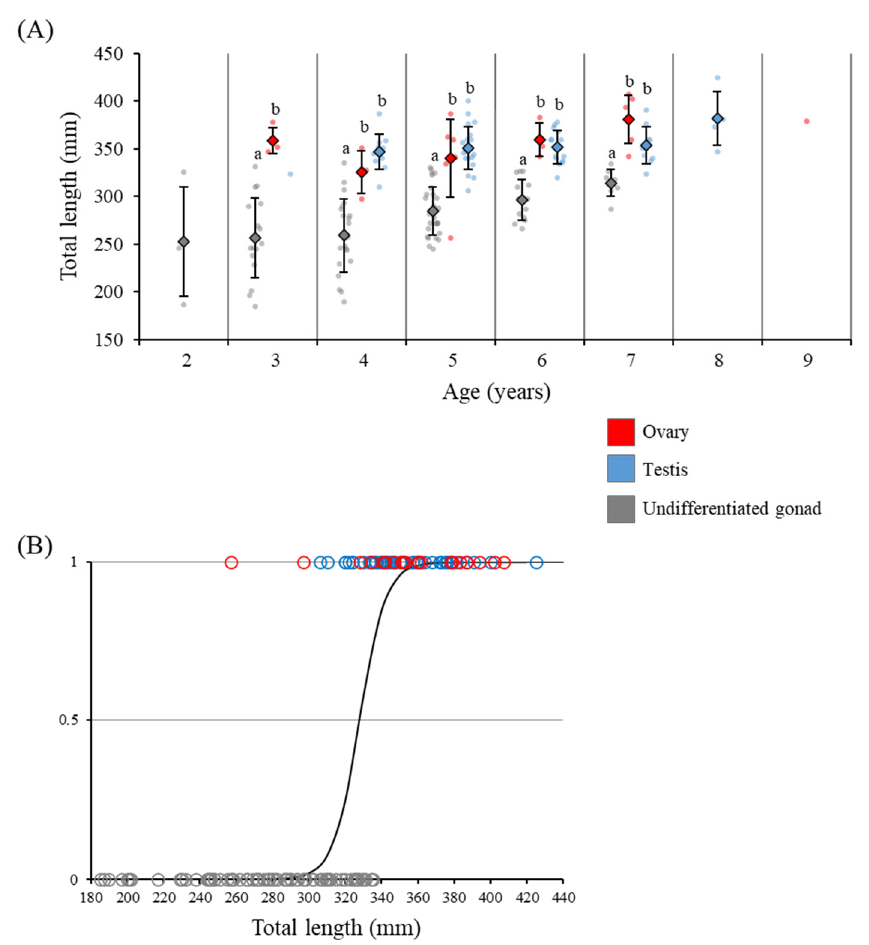
Figure 5. Relationship between the stage of gonadal development, TL, and age in the wild Japanese eel Anguilla japonica . ( A ) Different letters indicate significant differences ( P < 0.05) relative to the ovary, testis, and undifferentiated gonad. ( B ) TL with respect to morphological sex differentiation. Y, probability of gonadal sex differentiation. Table 3. Gonad samples of male and female Japanese eel used to